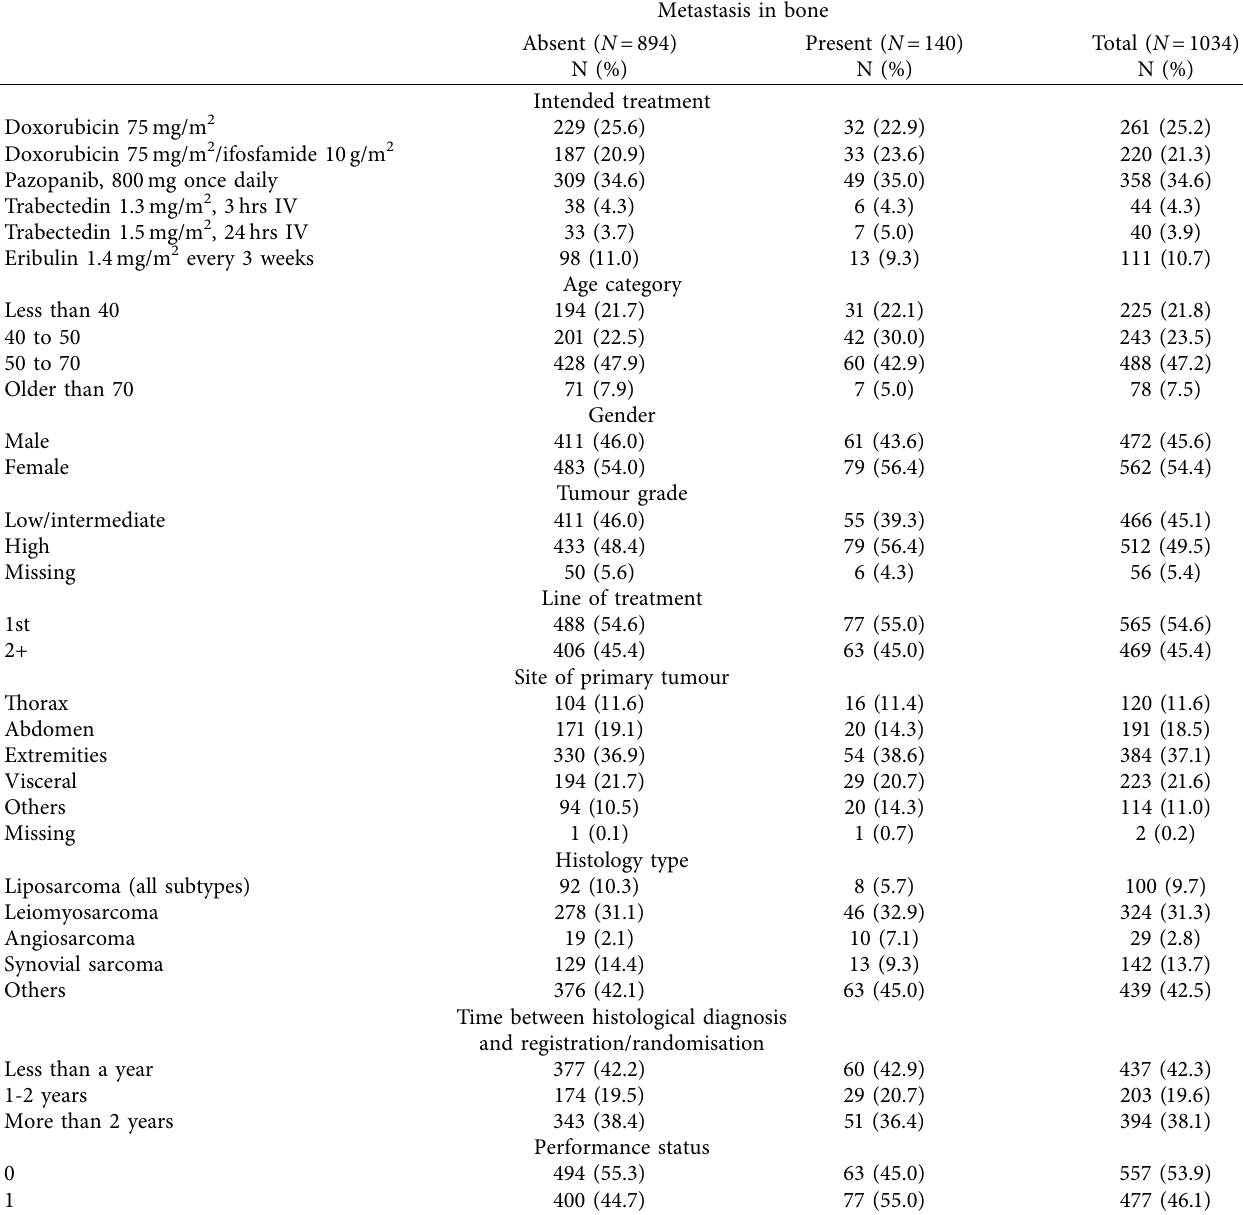
Table 1: Patient baseline characteristics versus metastatic profile in the